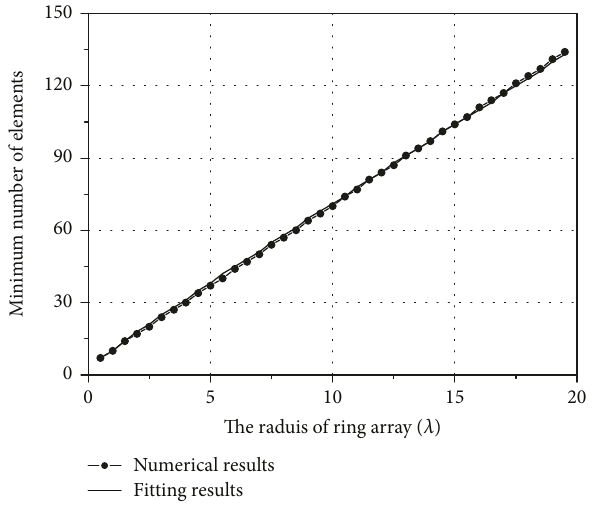
Figure 2: The minimum element number on di ff erent radiuses for ≤− 30 dB. the constraint of ς m fi tting line is plotted in Figure 2. It can be seen that the fi tting results are consistent well with the numerical results.